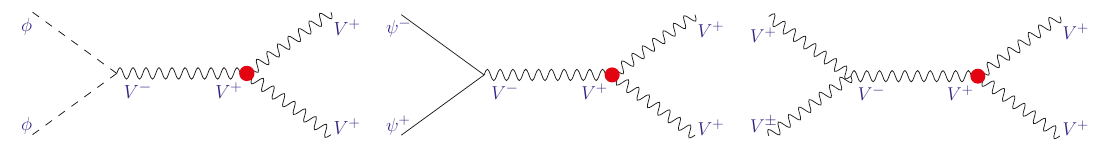
Figure 1 . Possible factorization channels of A [2] that contain a A ( V + V + V + ) part. The superscript 4 of a particle indicates the sign of its helicity, with the all-in/all-out convention. The diagrams with A ( V − V − V − ) can be obtained by flipping all the helicities. The red dot denotes an insertion of a dimension-6 operator. None of the processes are elastic in the helicity basis. Note in particular that A ( V − V − V + V + ) can not be generated by only one insertion of dimension-6